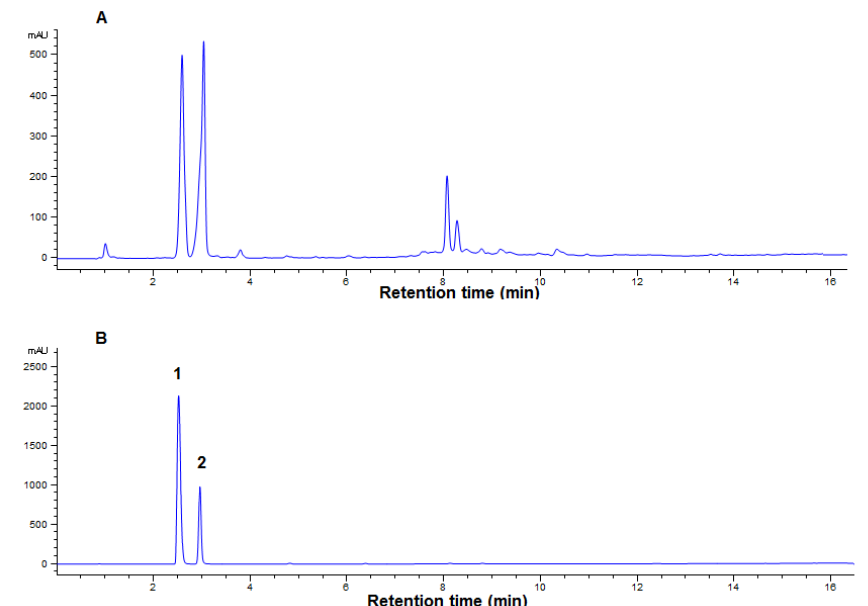
Figure 3. Ultra performance liquid chromatography (UPLC) chromatograms of methanol extract of A. helferiana and standard-mixture (compounds 1 and 2 ). A suitable UPLC condition was established and the UPLC chromatogram of methanol extract (5 mg / mL) of A. helferiana ( A ) was obtained. The standard compound 1 and 2 were mixed (1 mg / mL each) and the UPLC chromatogram was obtained under similar condition ( B ) maintaining same column condition and solvent system. The peaks in chromatogram of methanol extract were identified as compounds 1 and 2 peaks after comparing with the retention time and UV-spectrum with that of standard compound peaks in chromatogram B. Table 2. Quantification of compounds 1 and 2 in A. helferiana rhizome using calibration curve. Analytes Regression